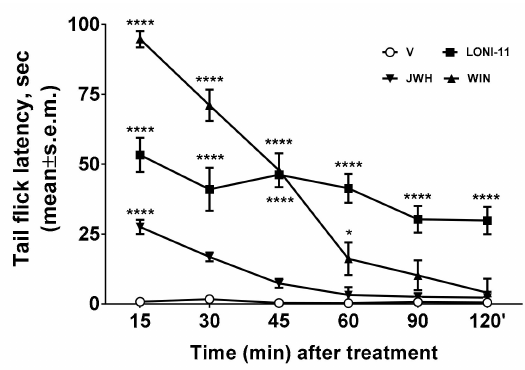
Figure 4. Antinociceptive e ff ect of JWH-018 (JWH), WIN 55,212-2 (WIN), LONI11 and vehicle (V, saline 0.1% v / v DMSO) at the dose of 10 µ g / 10 µ L after intracerebroventricular (i.c.v.) administration in the tail flick test. The antinociceptive activity is expressed as percentage of the maximum possible e ff ect (%MPE ± s.e.m.). * is for p < 0.05 and **** is for p < 0.0001 vs. V (vehicle-treated animals). N = 6.